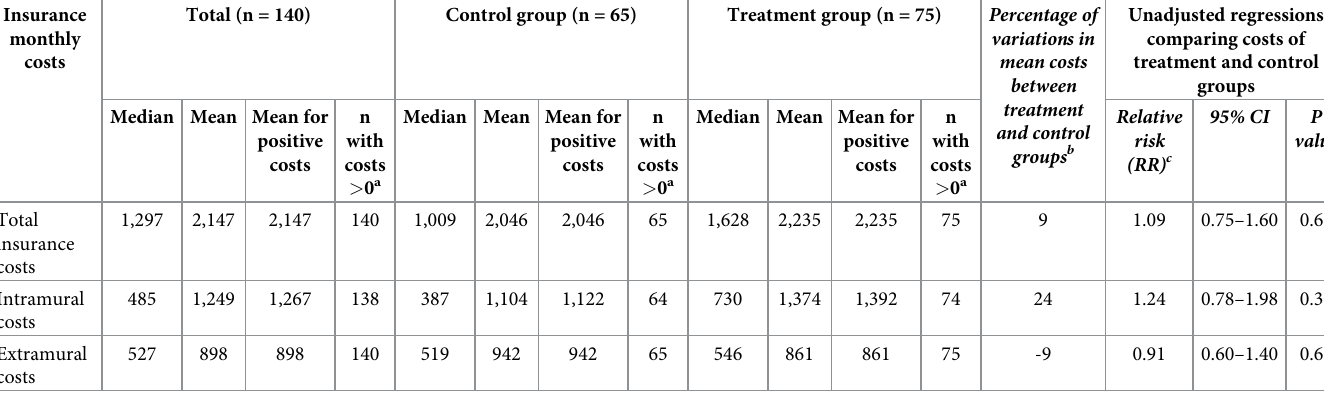
Table 4. Cost data from insurance perspective: Total, intramural, and extramural costs for control and treatment groups. Insurance monthly